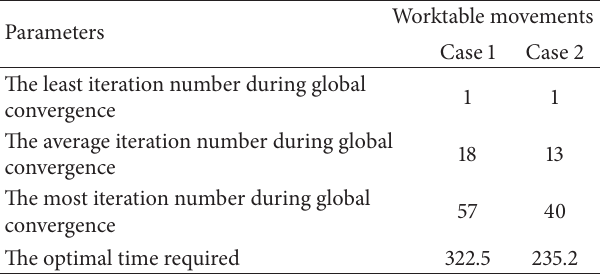
Table 1: Verification results for workpiece 1.